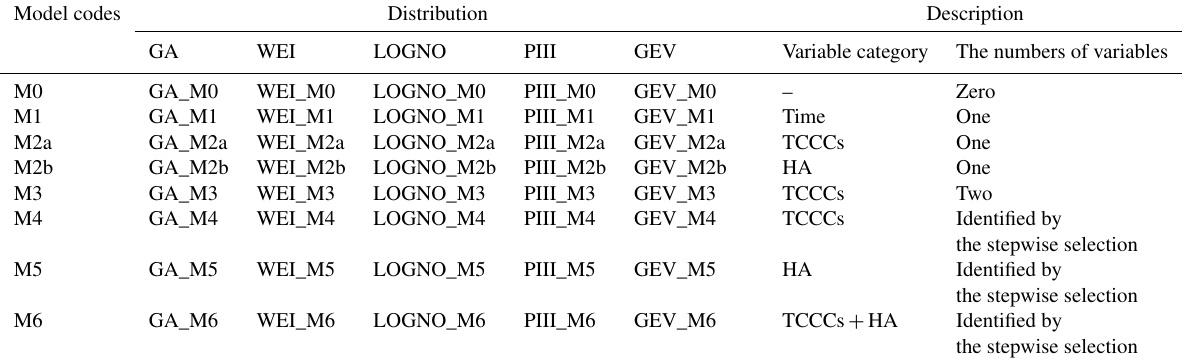
Table 2. Description of the developed nonstationary models using time, TCCCs indices and/or HA indices as explanatory variables. Model